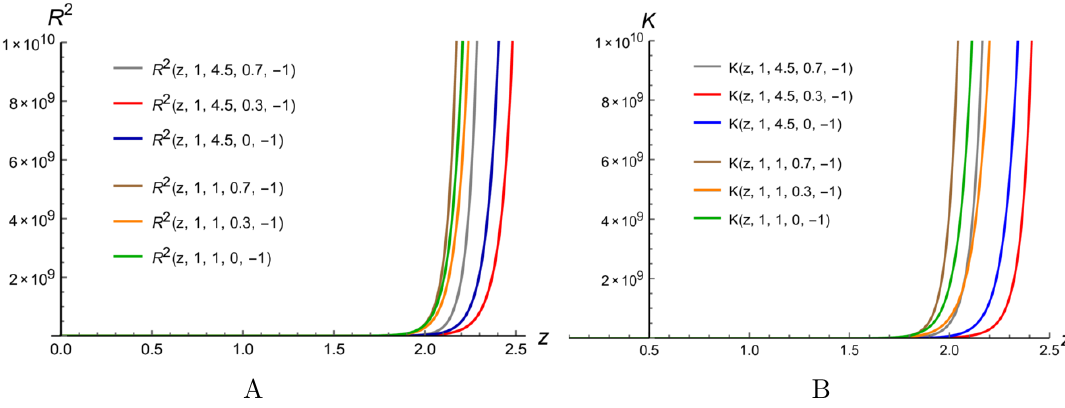
A B Figure 10 . Ricci R 2 ( z ) and Riemann K ( z ) invariants for z h = 1, c = (cid:0) 1 in isotropic, (cid:23) = 1, and anisotropic, (cid:23) = 4 : 5, cases for di(cid:11)erent (cid:22) .